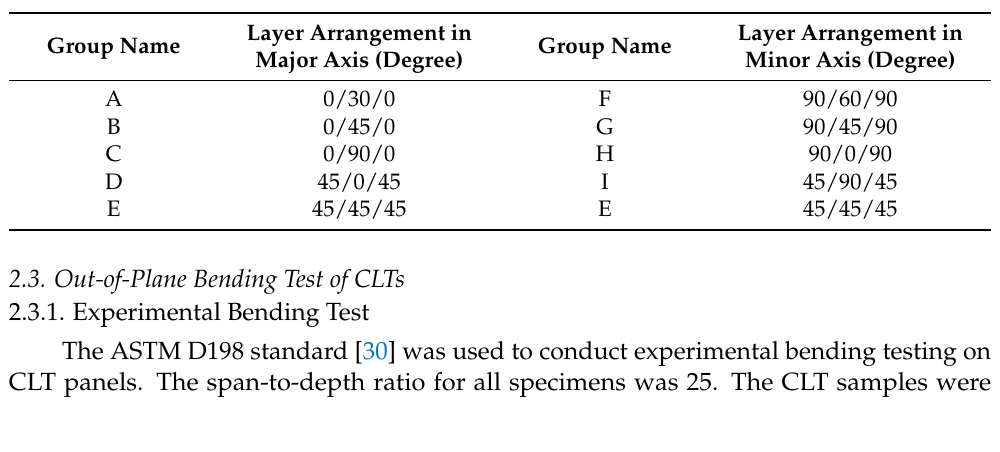
Table 2. CLT panels configurations used for the bending